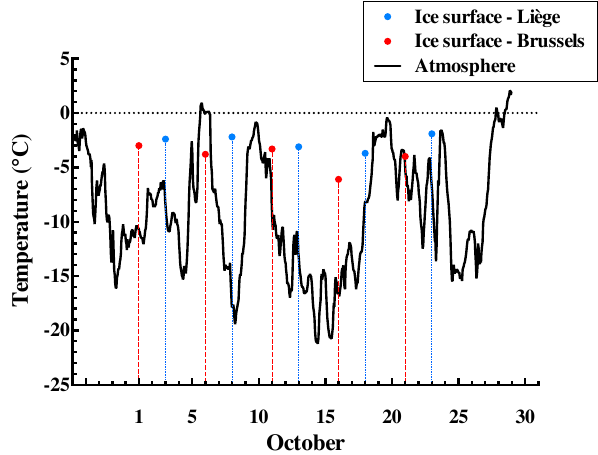
Figure 3. Daily time series of air temperature ( ◦ C) recorded on the ship and the surface ice temperature of the different sampling sta- tions at the Brussels (red dots) and Liège (blue dots)